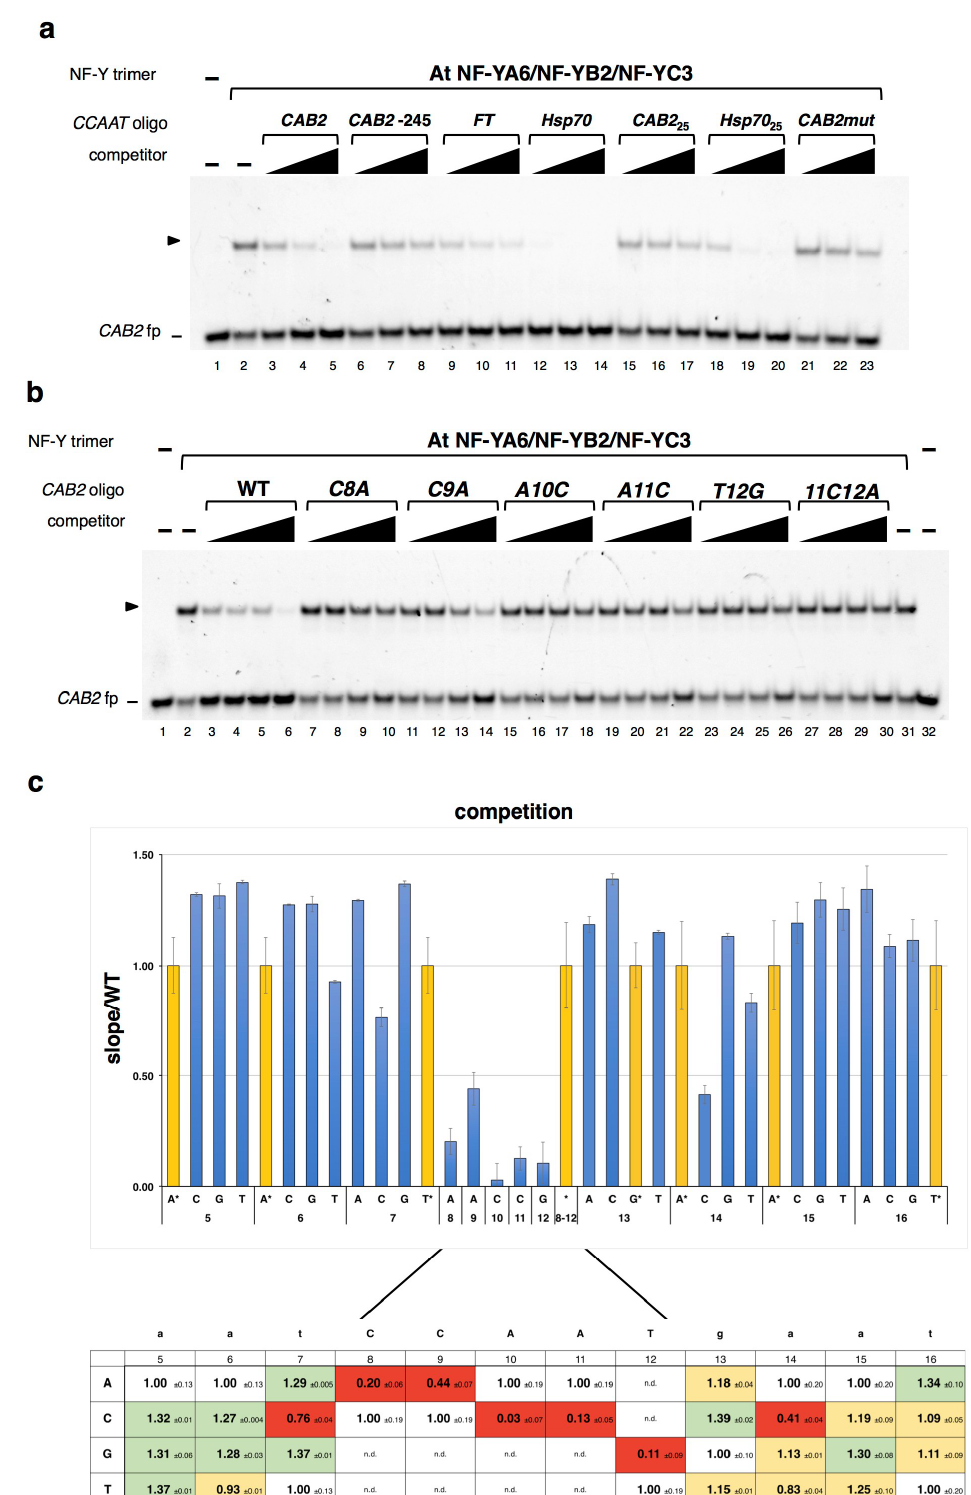
Figure 2. AtNF-Y binds CCAAT DNA with sequence-specificity. ( a ) EMSA competition analysis of AtNF-Y CCAAT box specificity. The At NF-YA6/NF-YB2/NF-YC3 trimer (30 nM) was incubated with the CAB2 CCAAT ( − 65) ( CAB2 ) probe (20 nM; lanes 2 − 23), with the addition of the indicated unlabeled competitor 31mer oligos at increasing concentrations (1X, 5X, 25X fold excess), or TE bu ff er alone (-) (lane 2). Lane 1: Probe alone. CAB2mut : CAB2 ( − 65) C8A mutant oligo. Hsp70 2 5 , CAB2 25 : 25 bp